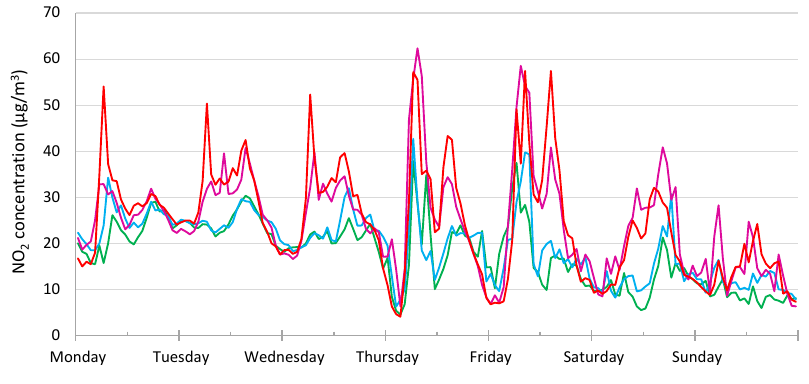
DETH081 Figure 7. Weekly seasonality NO 2 concentration for the four sensors (DETH020 blue, DETH043 violet, DETH081 red, DETH117 green), week from 9 November until 15 November